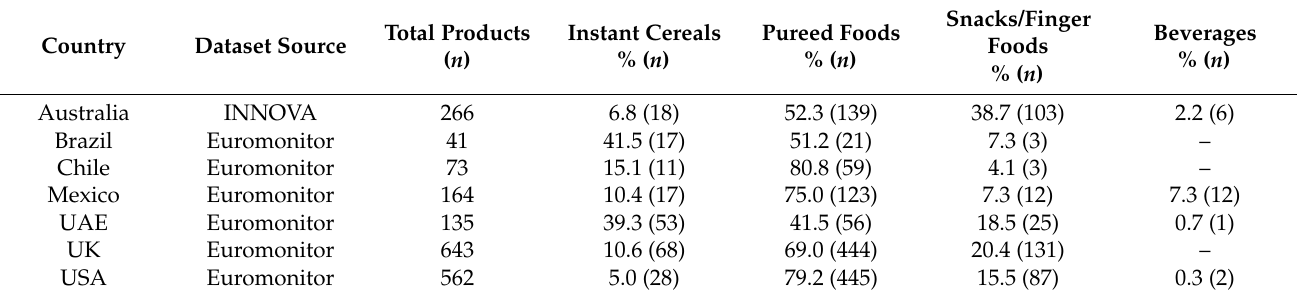
Table 2. Summary of commercially produced complementary foods identified.